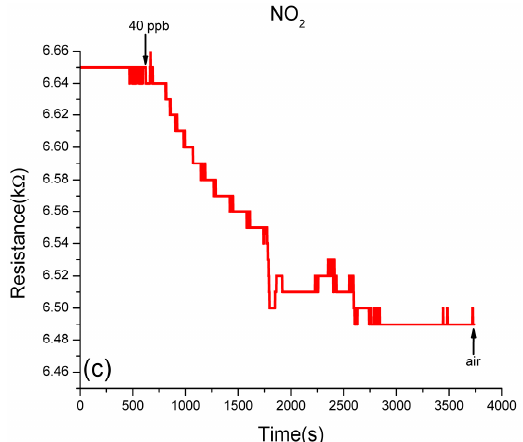
Figure 8. Sensing to different NO 2 exposure: ( a ) sensor response to exposure at different concentration of NO 2 in N 2 , starting from 40 ppb up to 200 ppb; ( b ) sensor repeatability to exposure at a concentration of 800ppb NO 2 in N 2; ( c ) sensor response to an exposure at a concentration of 40 ppb NO 2 in N 2.